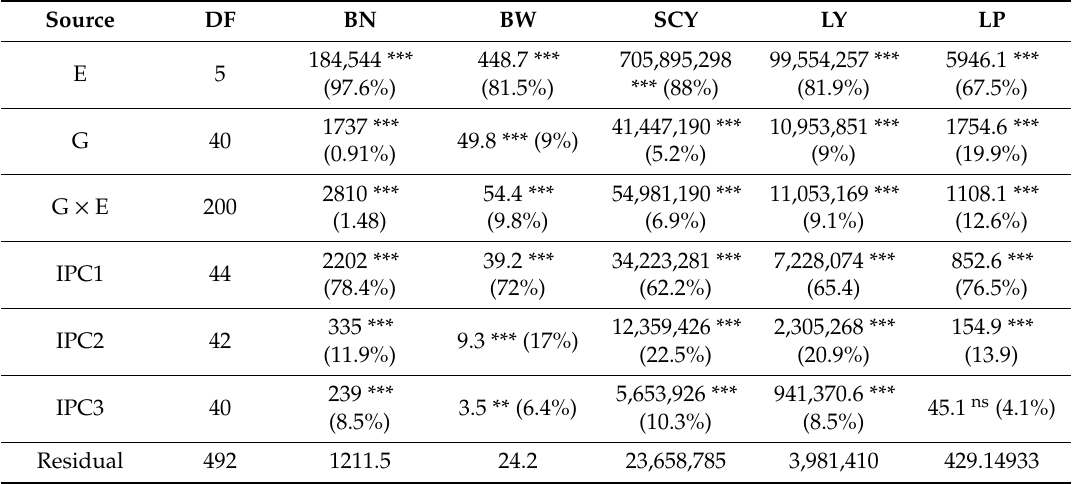
Table 3. Analysis of variance and partitioning of G × E interaction by AMMI model for yield